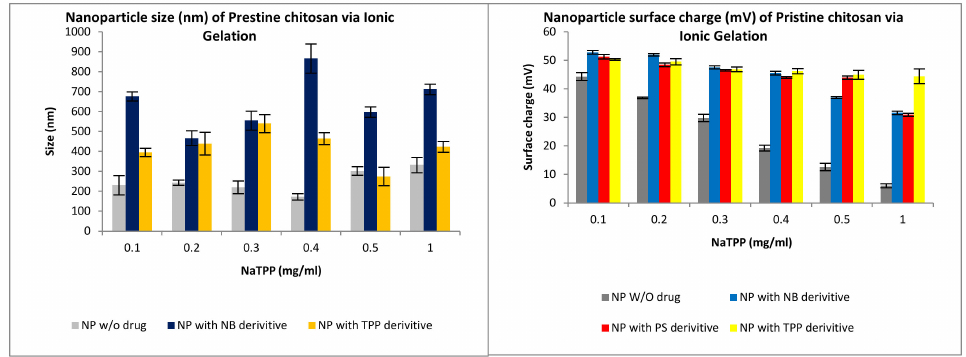
Figure 10. Size and surface charge characteristics of nanoparticles (NP) formulated via ionotropic gelation for compound 2 (TPP), compound 4 (NB) and compound 6 (PS).